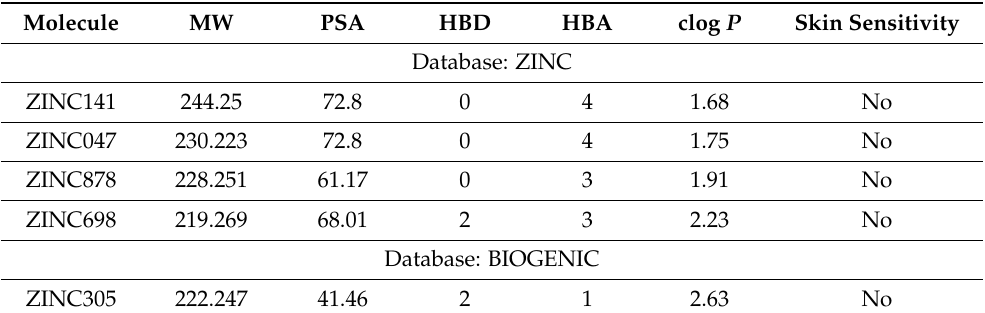
Table 1. Physicochemical prediction of selected molecules in the virtual screening step. clog P = octanol-water partition coefficient; PM = molecular weight (Da); HBD = hydrogen bond donor; HBA = hydrogen bond acceptor; PSA = polar surface area (Å 2